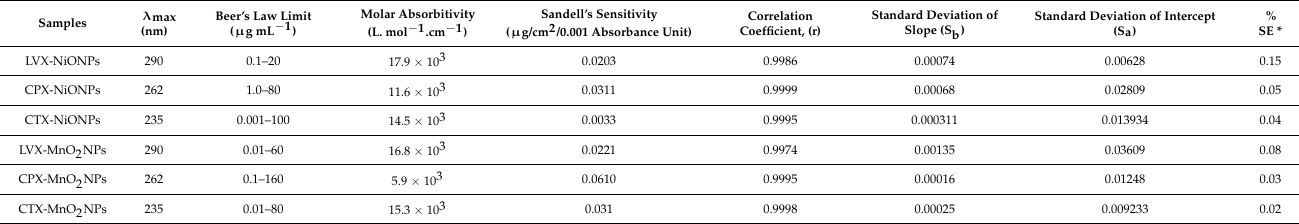
Figure 8. ( a – c ) The absorption spectra of 10 µg mL − 1 of LVX, CPX, and CTX solutions in the presence of NiONPS and ( d – f ) in the presence of MnO 2 NPs, respectively. Table 2. Response data obtained from the determination of LVX, CPX, and CTX using the proposed spectrophotometric method in the presence of NiONPs and MnO 2 NPs,